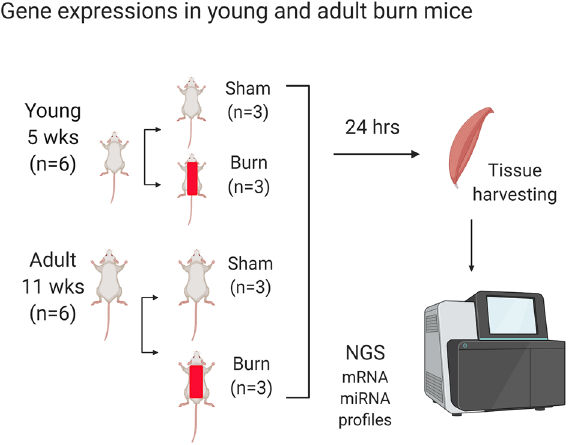
Figure 3. Experiment flow chart outlines the study design and sample processing. The Image was created in